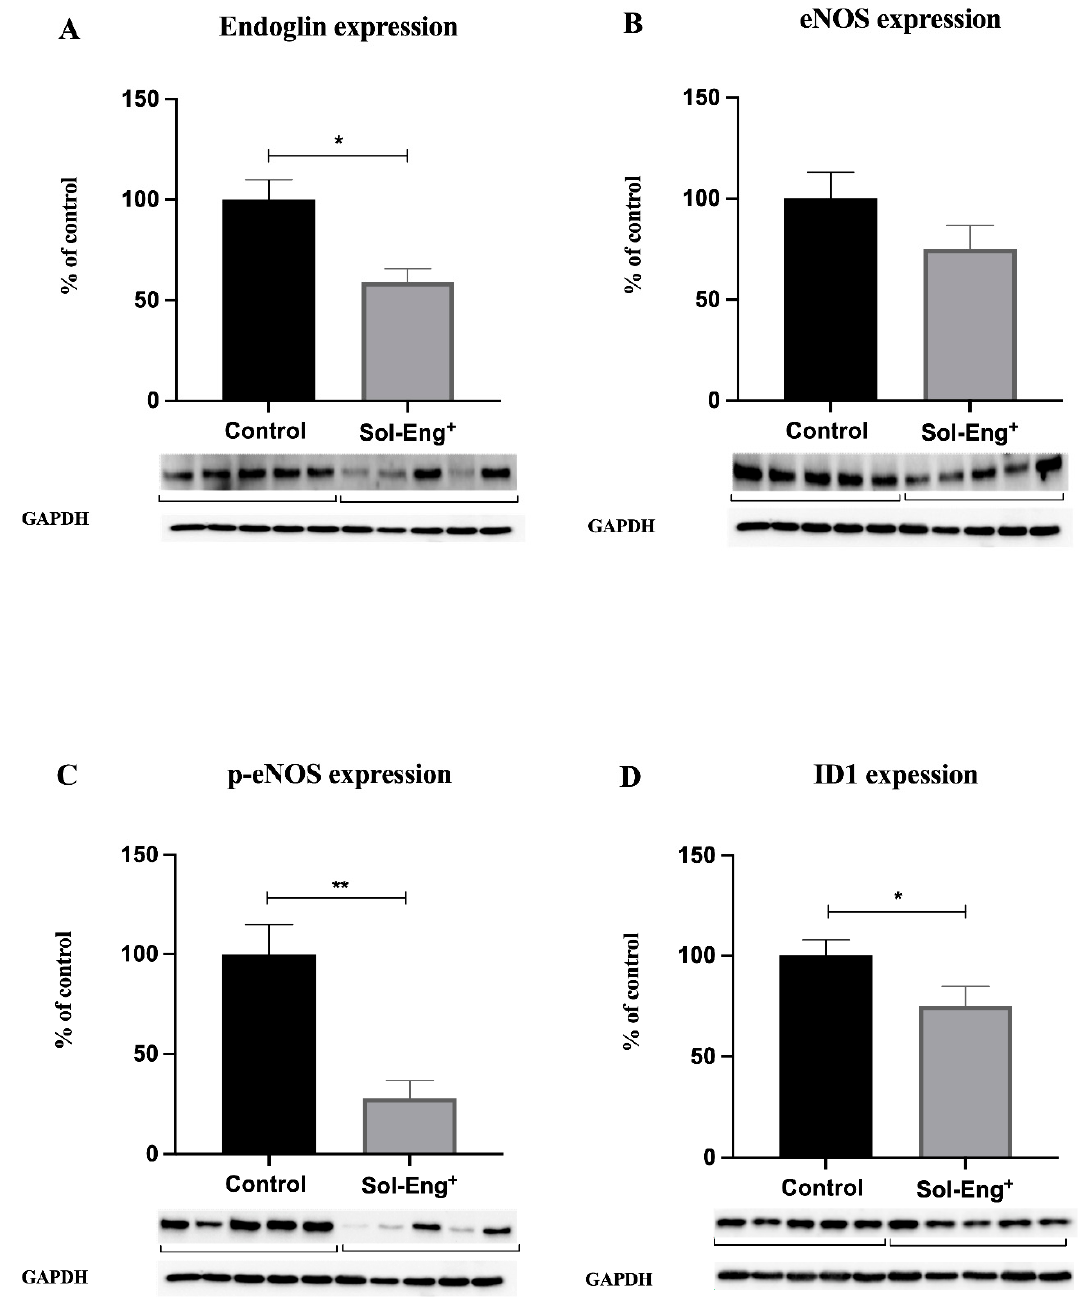
Figure 4. Expression of membrane endoglin and selected molecules belonging to its signaling pathway in aortas of twelve- month-old male Sol-Eng + and control mice. Expression of membrane endoglin ( A ), eNOS ( B ), p-eNOS ( C ), and ID1 ( D ) in total protein extracts from mice aortas. Densitometric quantification of immunoreactive bands (top panel: densitometric analysis, control = 100%) was recalculated to the GAPDH signal (bottom panel: representative immunoblots). Data are shown as mean ± S.E.M, Mann–Whitney test, * p ≤ 0.05, ** p ≤ 0.01. n = 5 mice per group.